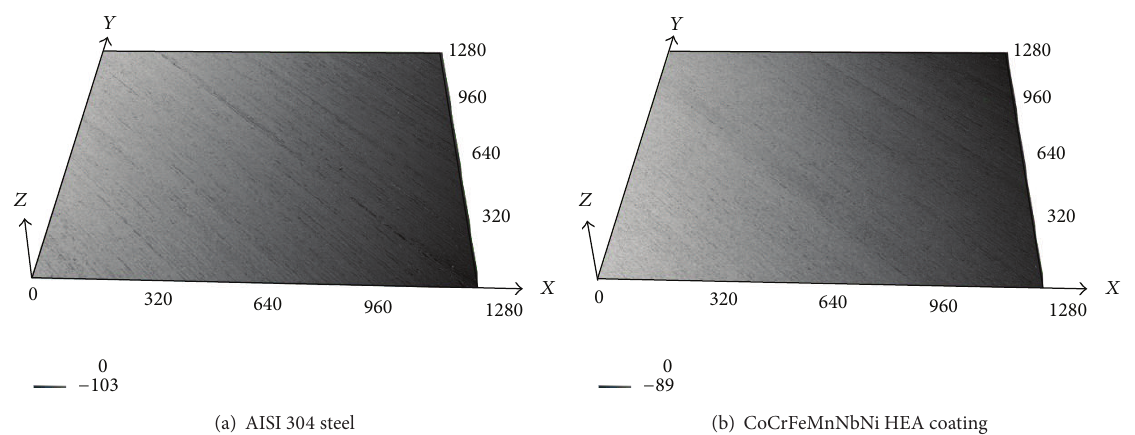
Figure 6: 3D microstructure of worn surfaces of AISI 304 steel and CoCrFeMnNbNi HEA coating ( 𝜇 m).